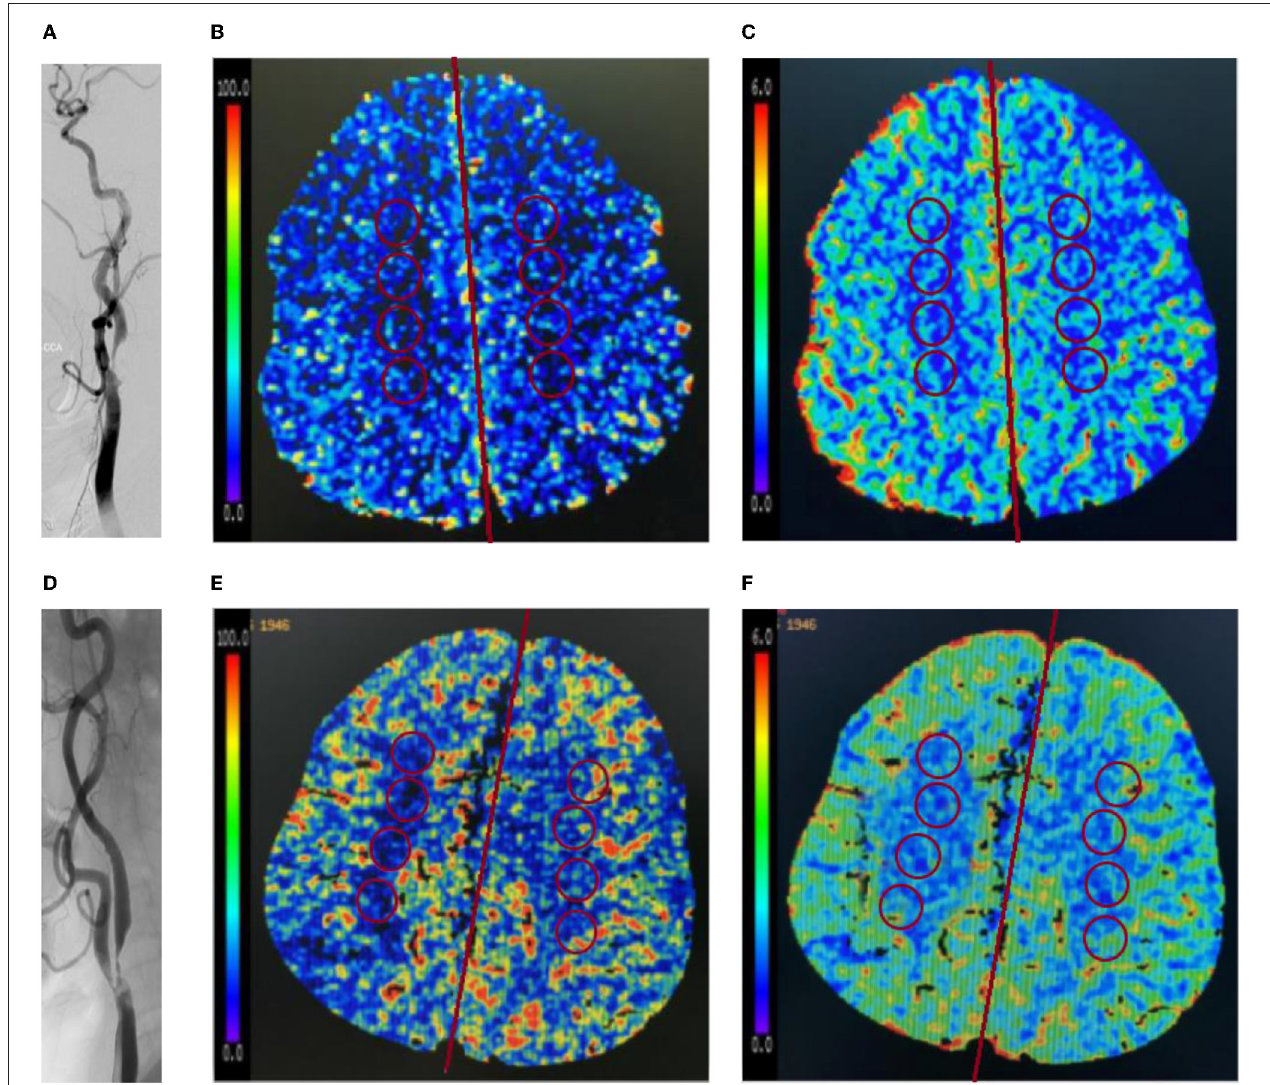
FIGURE 2 | Representative images of patients without or with impaired perfusion. (A–C) A 65-year-old female patient was hospitalized with mild headache and was diagnosed as severe stenosis of the right internal carotid artery (ICA) by digital subtraction angiography (DSA) (A) . The patient had no impaired perfusion. In the right internal watershed, cerebral blood flow (CBF) (B) decreased slightly, cerebral blood volume (CBV) (C) increased slightly, and CBF/CBV > 7.55/min. (D–F) A 73-year-old male patient was hospitalized with poor left limb activity, and was diagnosed as severe stenosis of the right ICA by DSA (D) . The patient had